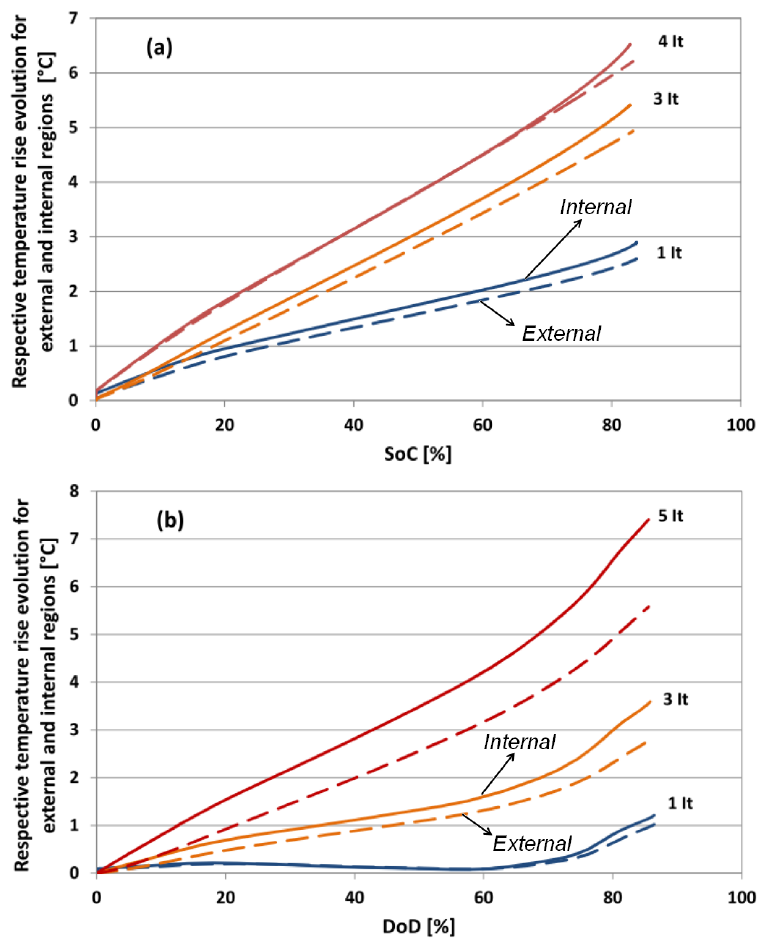
Figure 16. Temperature increases of the surface and the homogeneous internal regions for constant: ( a ) charge and ( b ) discharge of the cell. SoC: state of charge; and DoD: depth of